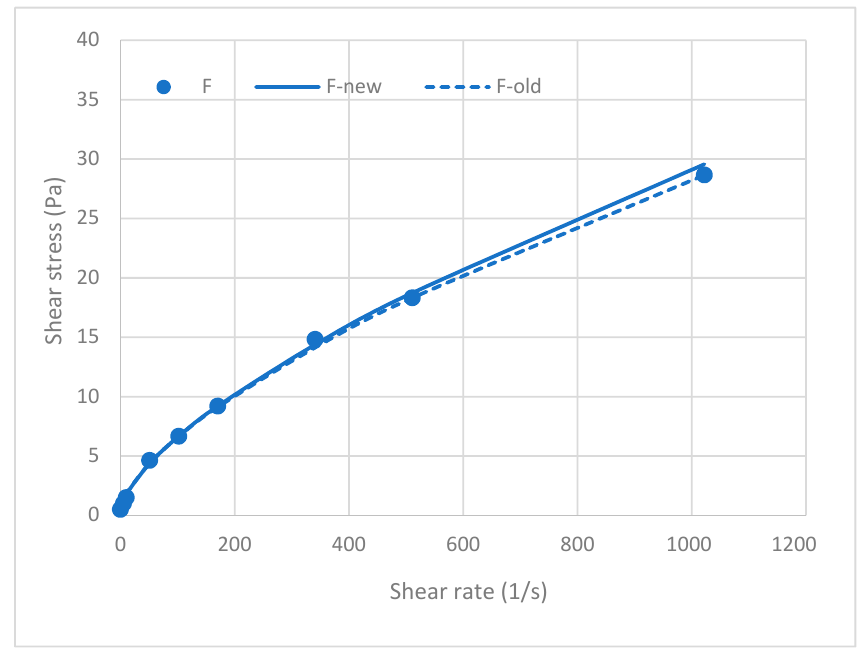
Figure 6. Flow curves of drilling fluid F assume one dial reading lower value at 102.2 1/s shear rate.